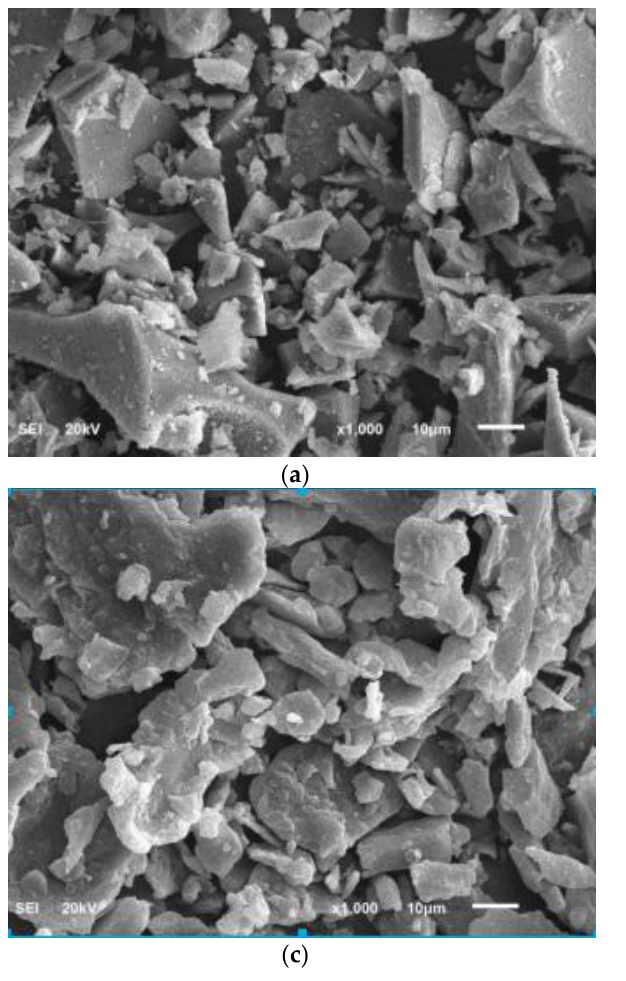
Table 2. Physical properties of DKA, FA, and NP.